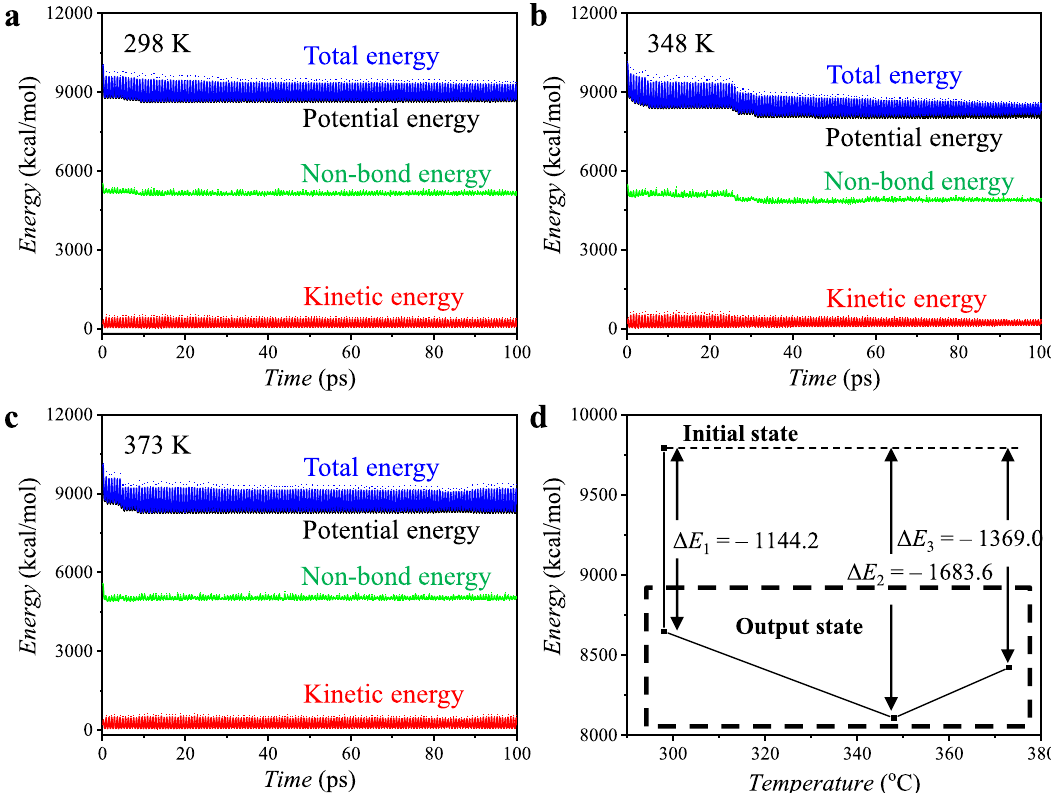
Fig. 6 Energy evolution curves of PAzoMA 5 in a crystalline cell from MD simulations at different temperatures. a 298, b 348, and c 373 K. d Illustrative analysis of energy state and Δ E calculated from MD simulations at 298, 348 and 373 K, respectively.